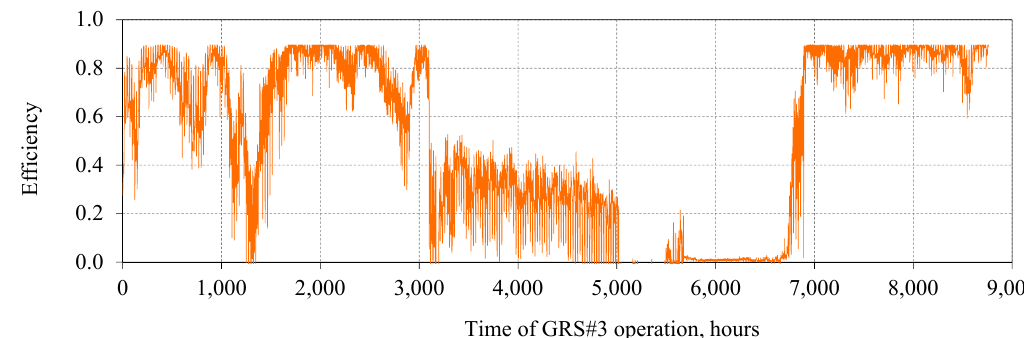
Figure 13. Expander efficiency for GRS #3 over a period of one year.